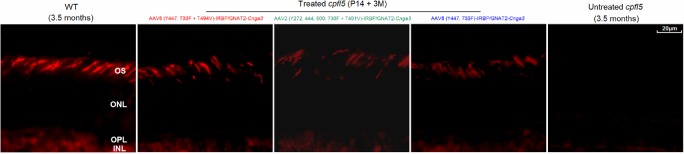
Immuno-staining of retinal CNGA3 at 3 months post-injection.CNGA3 expression (red) was detected primarily in the photoreceptor OS following treatment with AAV8 (Y447, 733F + T494V), AAV2 (Y272, 444, 500, 730F + T491V), or AAV8 (Y447, 733F). Age-matched WT and untreated cpfl5 retinas were used as controls. OS, outer segment; ONL, outer nuclear layer; OPL, outer plexiform layer; INL, inner nuclear layer.